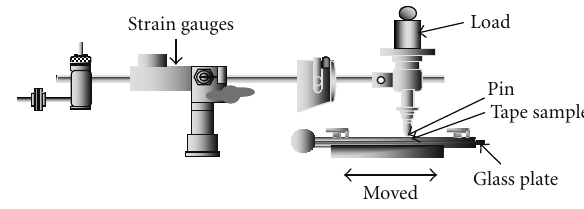
Figure 15: Schematic diagram of pin-on-flat friction tester.